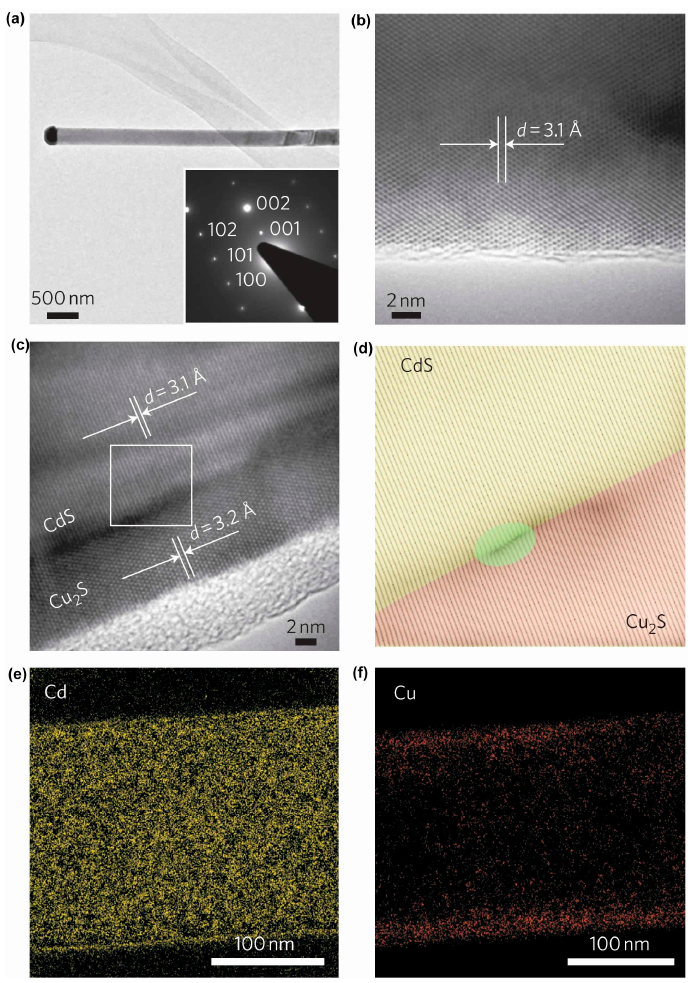
Figure 3. Structural characterization of CdS and CdS-Cu 2 S core-shell nanowires. ( a ) Representative TEM image of an as-grown CdS nanowire with its tip capped by a gold nanoparticle. Inset: electron diffraction pattern taken on the single crystalline nanowire. ( b ) High-resolution TEM image of an individual CdS nanowire, showing the single crystalline structure. ( c ) High-resolution TEM image of a CdS-Cu 2 S nanowire at the heterojunction. ( d ) Constructed inverse FFT image along the growth direction for the area marked in c. The green area shows the typical lattice fringe distortion at the core-shell interface (see Supplementary Information). ( e , f ) EELS elemental mapping images for: Cd ( e ); and Cu ( f ). Reproduced with permission from [27], Copyright 2011, Nature Publishing Group.